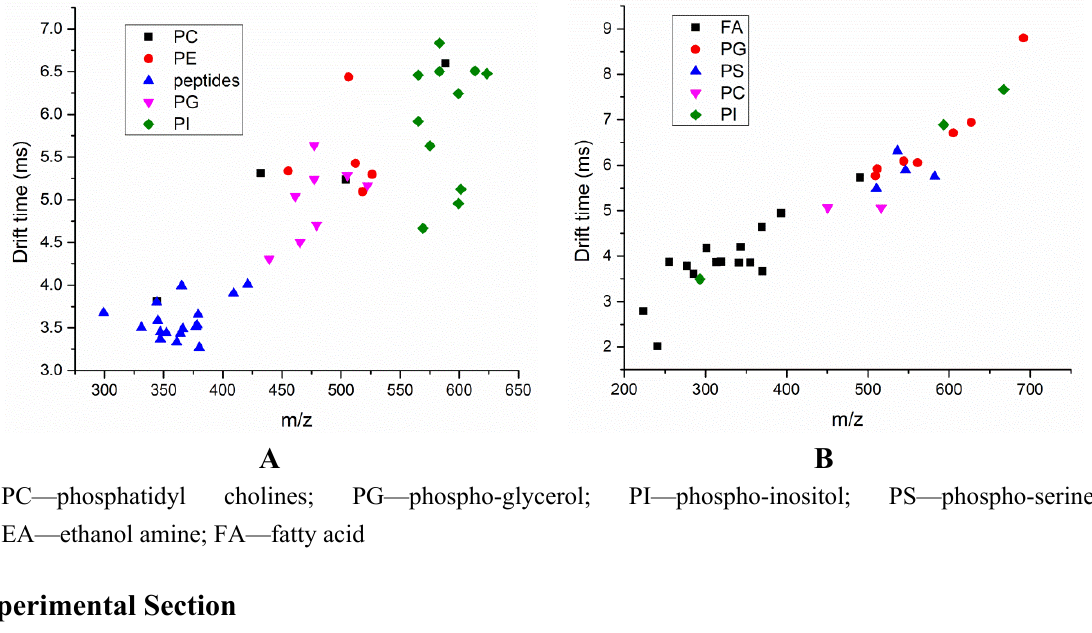
Figure 5. Ion mobility correlation analyses for the significant features identified in ( A ) positive and ( B ) negative ionization modes. Data were acquired in low energy IMS-MS E mode, and the tentative compound identifications were obtained based on their accurate mass